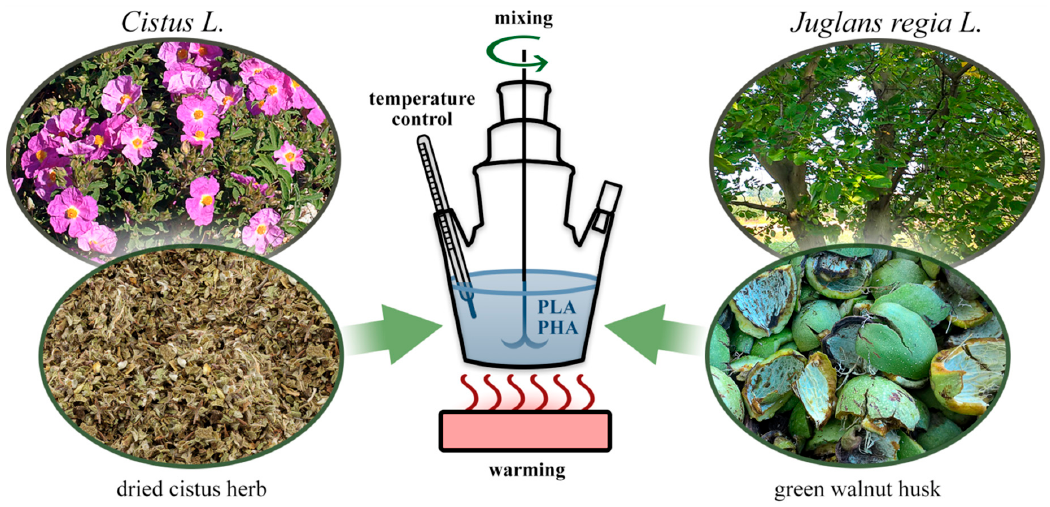
Figure 1. Scheme of apparatus and plant materials used in the impregnation of polymers.